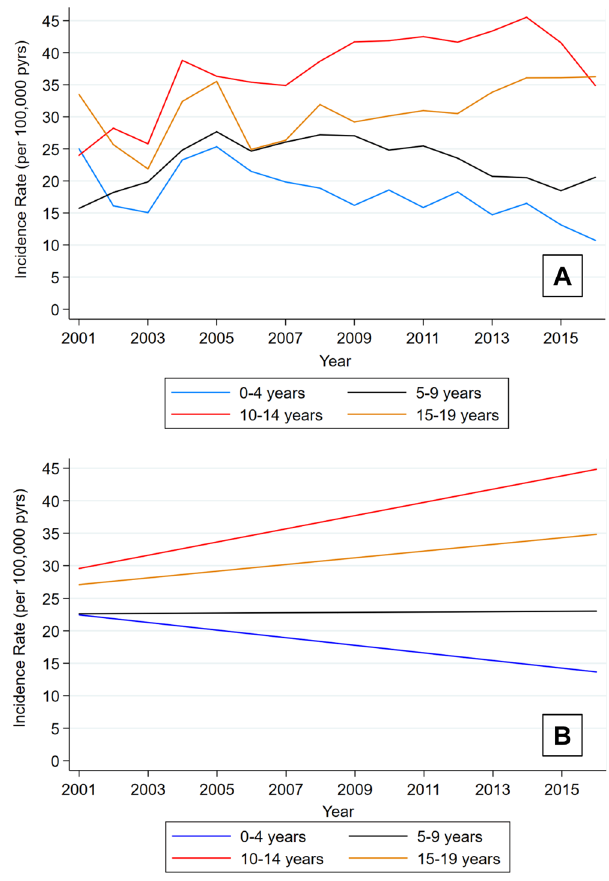
Figure 3. Incidence Rates of Type 1 Diabetes in the United States, Ages 0–19, Years 2001–2016 ( A : Rates and B : Linear